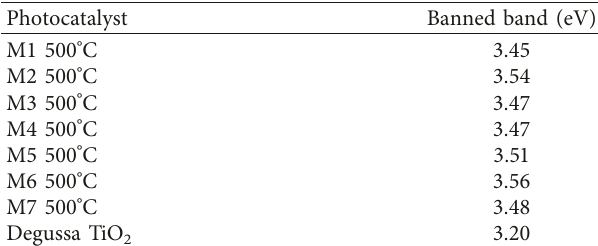
Figure 8: (a) UV-Vis reflectance diffuse spectra of activated hydrotalcites at 500 ° C with different Mg/Al molar ratios before photoreaction. (b) Kubelka–Munk transformed diffuse reflectance spectra. Table 3: Banned band energy of activated hydrotalcites determined from the Tauc